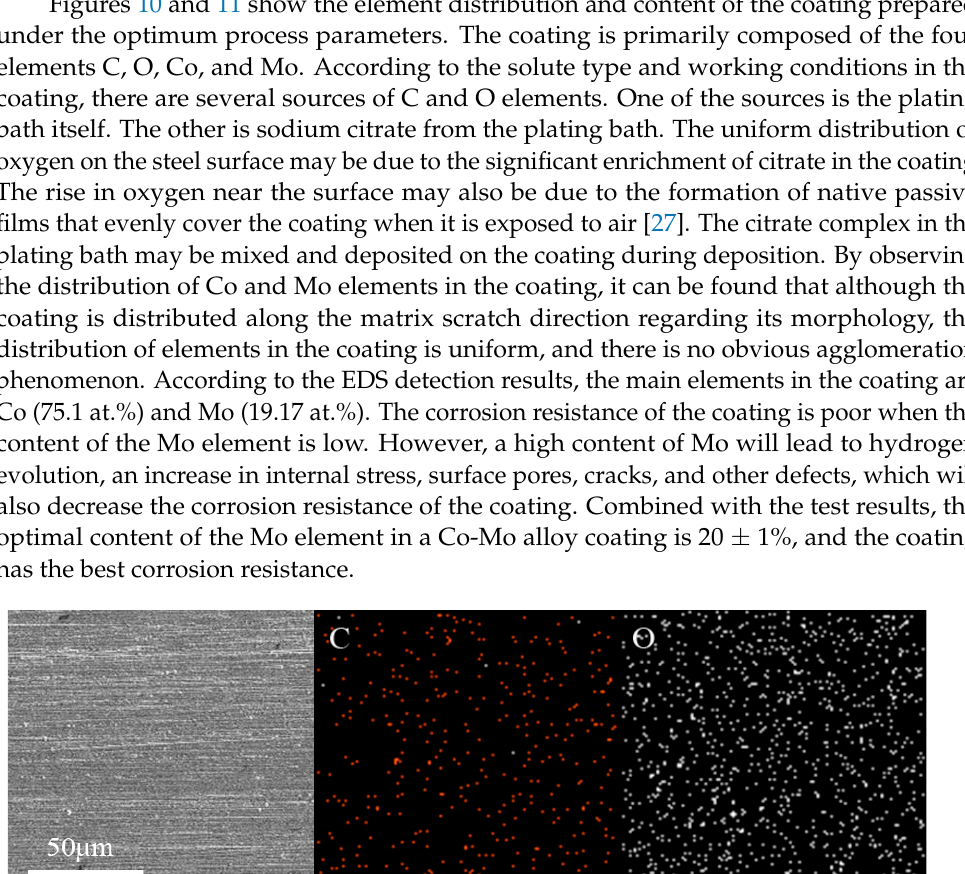
Figure 11. EDS spectrum and chemical composition of Co-Mo alloy coating. 4. Conclusions In this paper, the kinetic process of electrodeposition of a Co-Mo coating was studied using cyclic voltammetry and electrochemical impedance. The e ff ects of sodium molybdate content, deposition temperature, pH value, and other technological parameters on the deposition kinetics of alloy coatings were studied. The deposition processes of Co and Co-Mo coatings at di ff erent potentials were studied by electrochemical impedance testing. The results are as follows: (1) As the content of sodium molybdate increases, more Mo elements participate in the deposition process, and the current density of the cathode reduction reaction increases. At the same time, a higher Mo content can reduce the dissolution of the coating as an anode and improve the service life of the coating. However, excessive Mo element content will lead to cracks on the surface of the coating and a ff ect its performance.